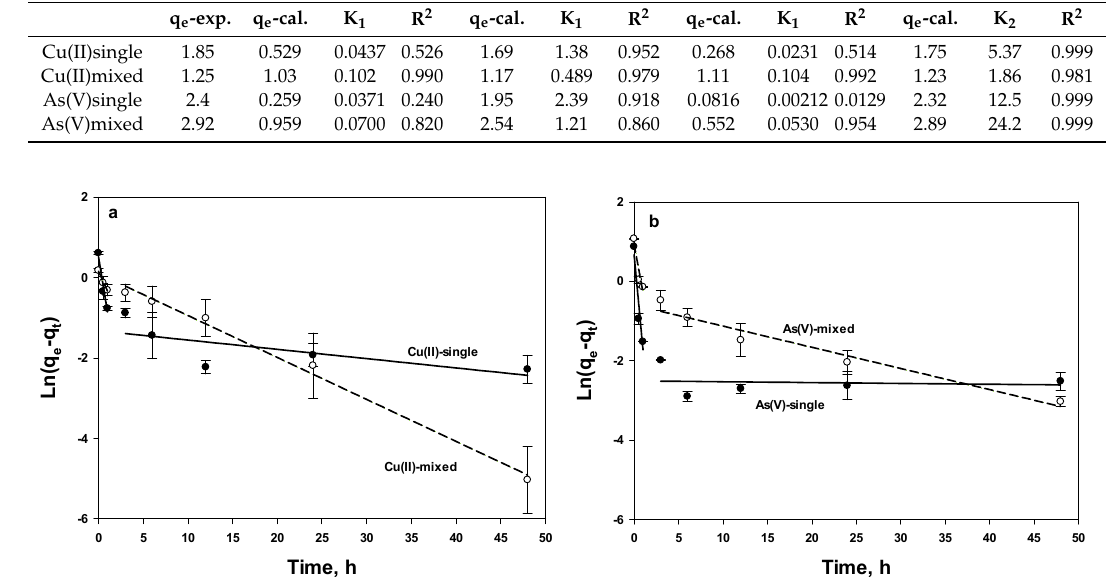
Table 2. Kinetic parameters for the linear PFO and PSO models for Cu(II) and As(V) in single and mixed solutions. PFO PSO Without Separation t ≤ 1 t ≥ 3